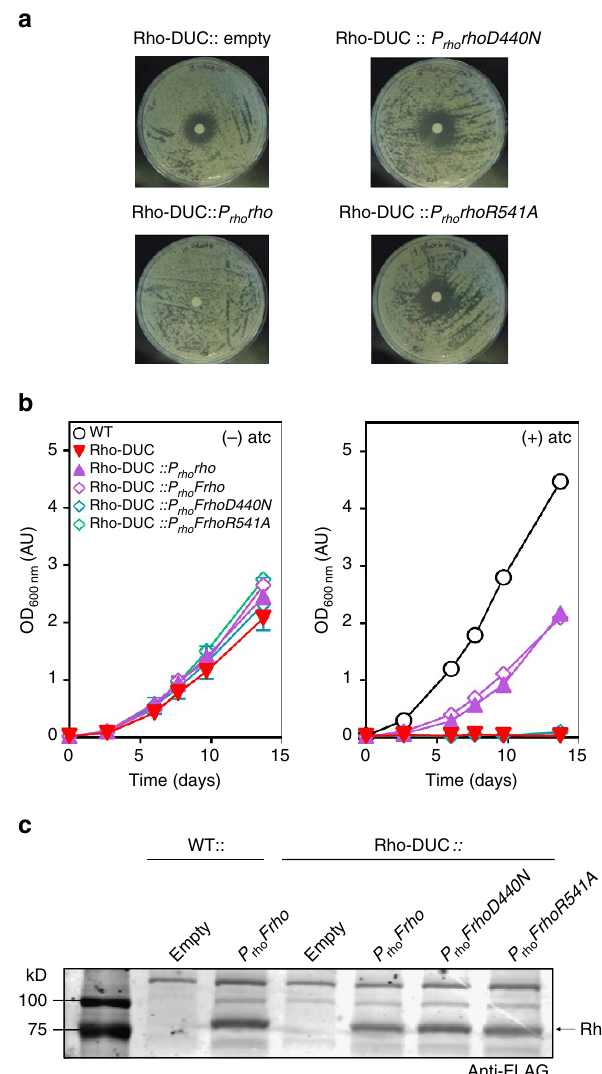
Figure 5 | Importance of ATP binding and hydrolysis for Rho. ( a ) Complementation of Rho-DUC on solid medium. The growth inhibitory effect of Rho depletion by addition of atc was assayed on the Rho-DUC strain that constitutively expresses a second copy of WT Rho ( P rho rho ), or Rho-D440N or Rho-R541A ( P rho rhoD440N and P rho rhoR541A ). Approximately 100ng of atc was added on the discs. ( b ) Complementation of Rho-DUC in liquid medium. The Rho-DUC strain constitutively expresses the second copy of WT Rho ( P rho rho ), or a FLAG-tagged WT Rho ( P rho Frho ), or a FLAG-tagged Rho-D440N or a FLAG-tagged Rho-R541A ( P rho FrhoD440N and P rho FrhoR541A ). Data are means of duplicate cultures ( ± s.d., some error bars too small to be seen). ( c ) Western blot of protein lysates using an anti-FLAG antibody of samples grown in the absence of atc in ( b ). The entire blot is shown in Supplementary Fig.